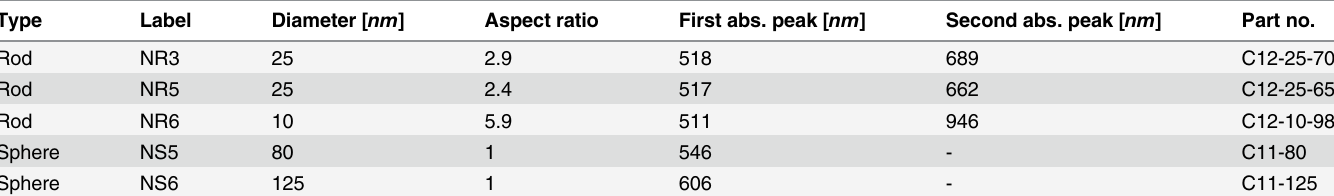
Table 1. The studied GNPs (from Nanopartz Inc.).